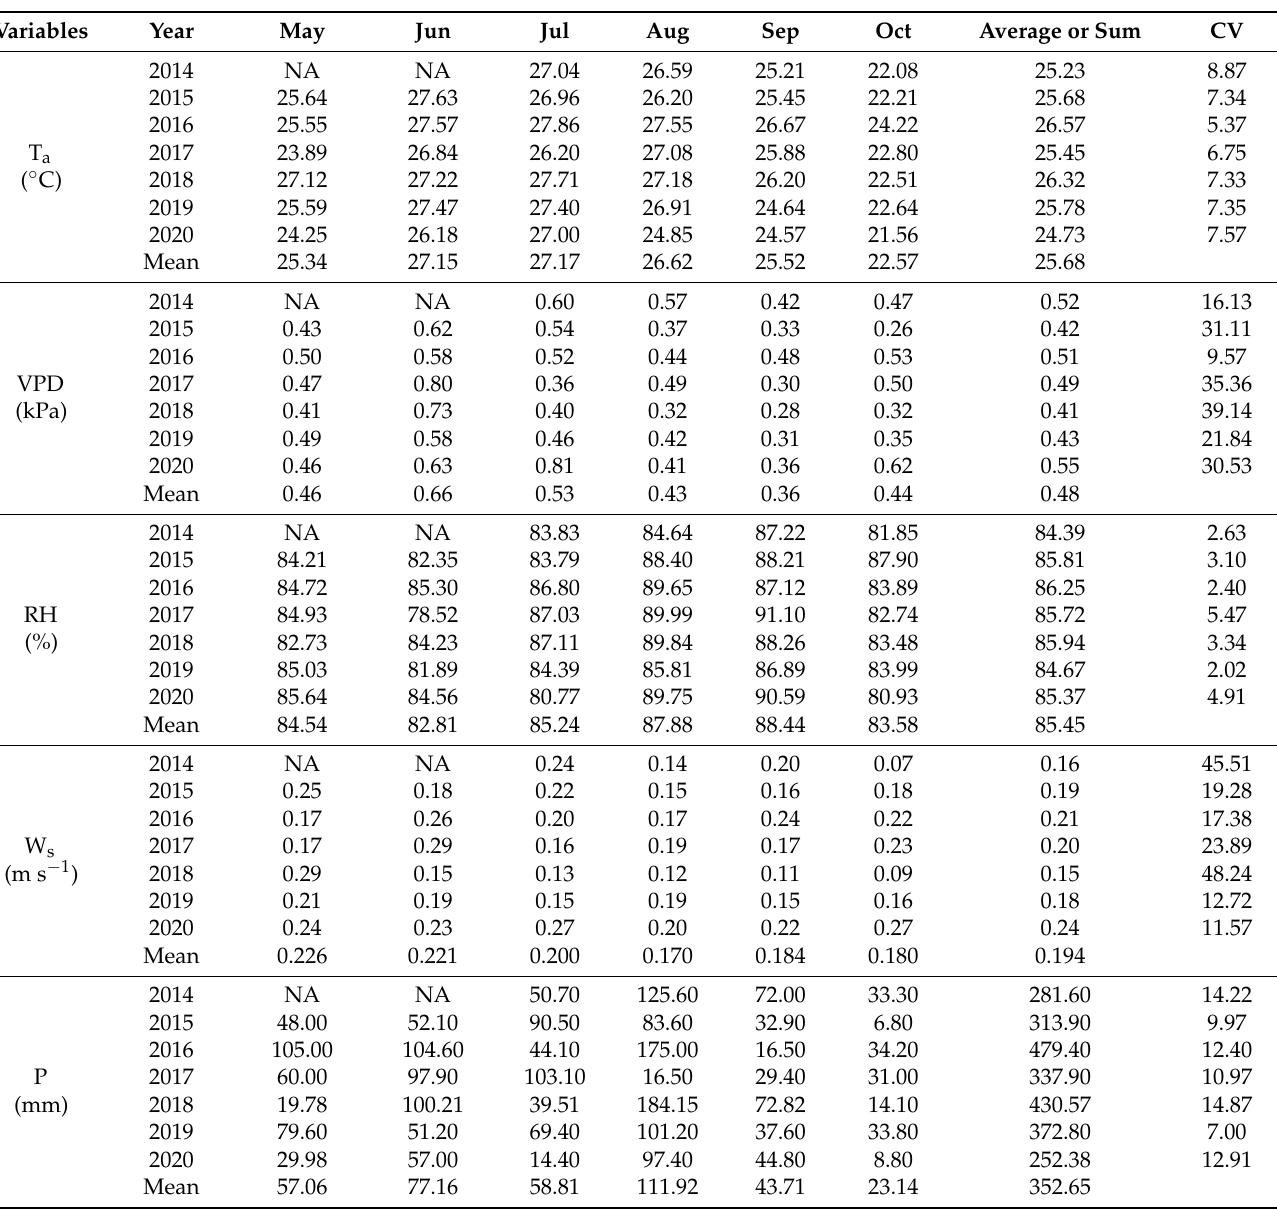
Table 1. Seasonal and interannual variation in nighttime micro-hydrometeorological parameters, sap flow (Q n ) and the ratio of nighttime to 24-h sap flow aggregation (Q n /Q 24-h × 100) over the growing season (1 May–31 October) of the 2014–2020 observation period. In the table, “CV” and “NA” stand for coefficient of variation and not available,